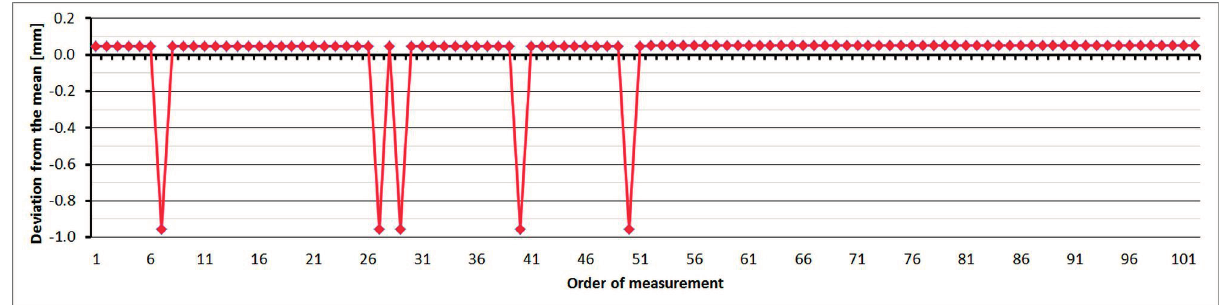
Figure 21. Leica TC1800–Differences from average distance–pillar 7 (13.9